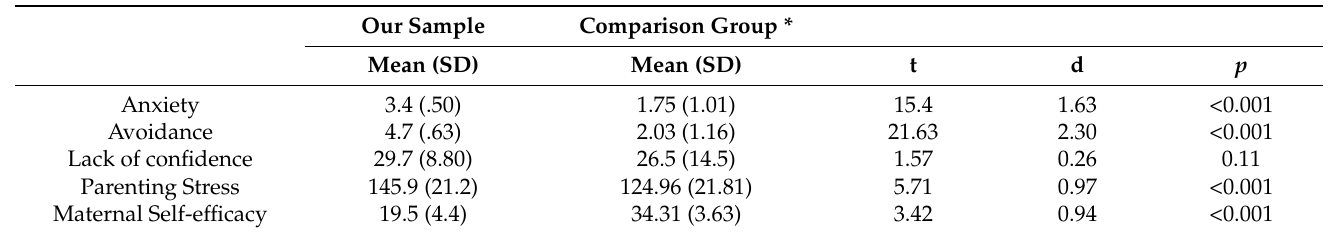
* Comparison groups: Sibley, Fischer, Liu (2005) for the attachment dimensions; n = 82 [56]; Wolke e St James Robert (1987) for the lack of confidence; n = 40 [57]; Epifanio et al. (2015) for parenting stress; n = 53 [58]; Fulton et al. (2012) for maternal self-efficacy; n = 108 [59].